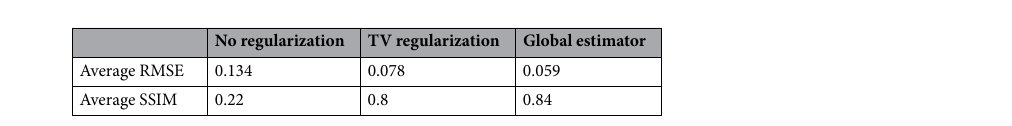
Figure 6. Reconstruction of a moving resolution target. ( a ) Estimated motion of the resolution target. ( b ) From left to right: reconstruction with inversion of S-matrix, TV regularization and global estimator. Zoom in to pattern 3.2 on resolution target, showing improvement.